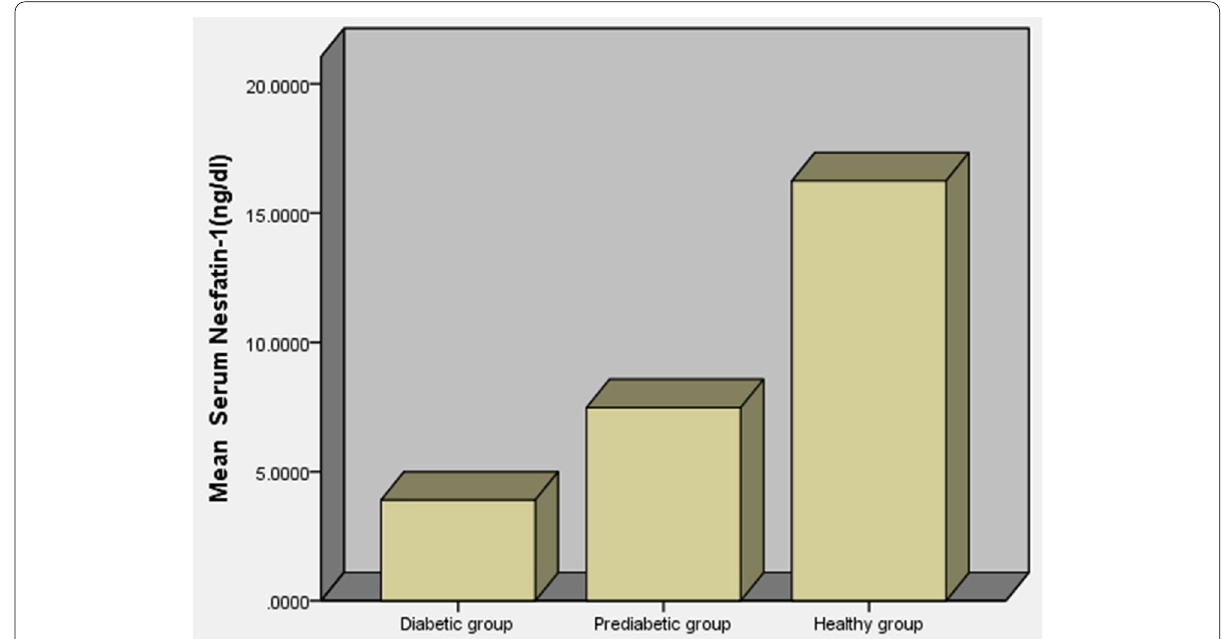
Fig. 1 serum nesfatin‑1 levels in diabetic, pre‑diabetic, and healthy